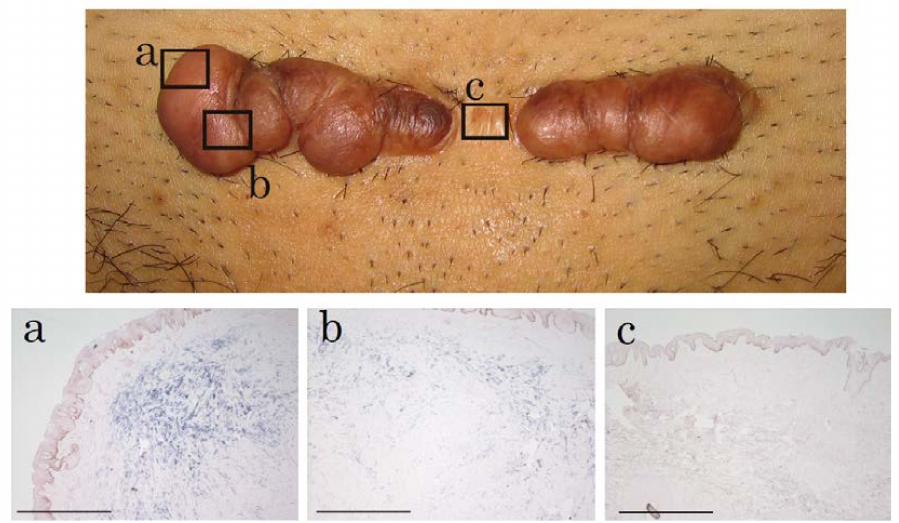
Figure 2. An abdominal keloid after laparoscopic surgery. The activity of keloid was in order a, b and c. Higher activity in regions of the lesion were associated with increased cell proliferation and greater up-regulation of HtrA1. Scale bar = 500 µ